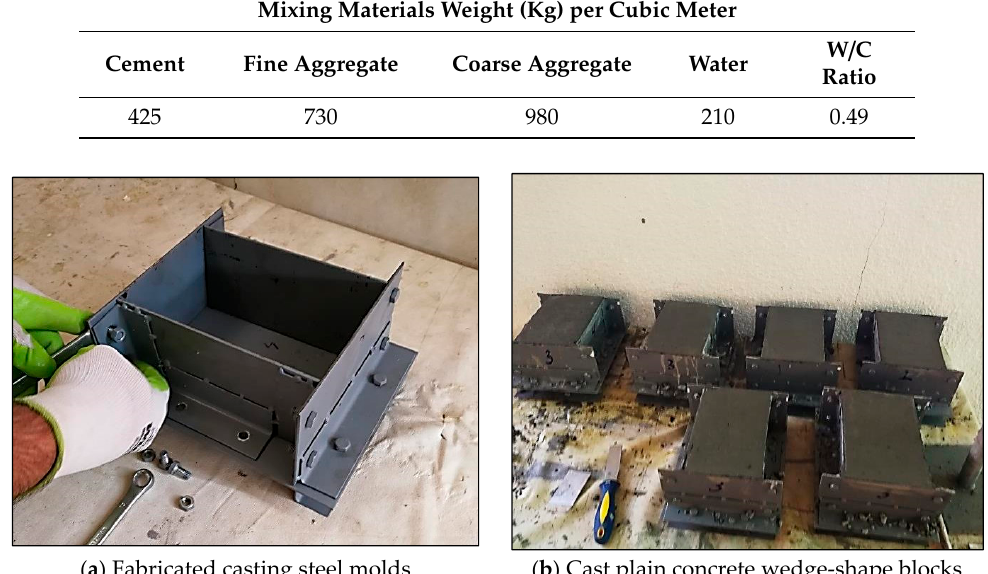
Table 1. Mix proportions of designed concrete.